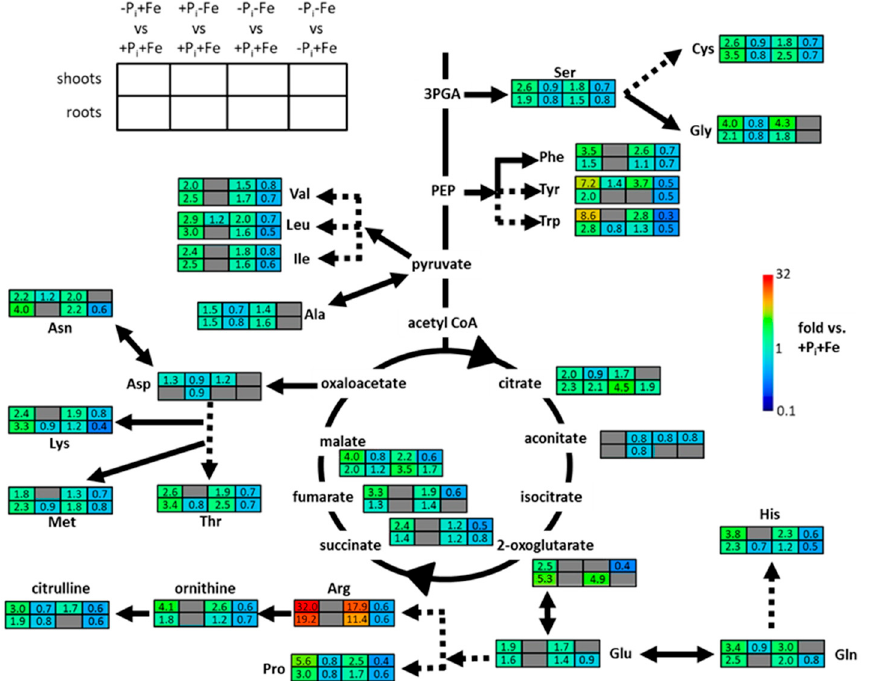
Figure 3. Metabolic changes in Col-0 plants presented in the form of a core metabolism overview, modified based on MAPMAN [42]. Upper and lower rows indicate the normalized metabolite concentrations (normalized to +P i +Fe) in shoots and roots, respectively, after treatment with P i ( − Pi+Fe), Fe (+P i − Fe) and combined P i and Fe ( − Pi − Fe) deficiencies (columns from left to right). Columns to the right represent the ratios between metabolite levels after combined P i and Fe deficiency ( − Pi − Fe) and P i deficiency ( − Pi+Fe). Cells colored in gray indicate no difference to plants grown under nutrient sufficient conditions (+P i +Fe) or between − Pi − Fe and − Pi+Fe treatments at p ≤ 0.05 (Student´s t -test, two tailed, equal variances, n ≥ 27). The numbers refer to the values shown in Dataset S3.